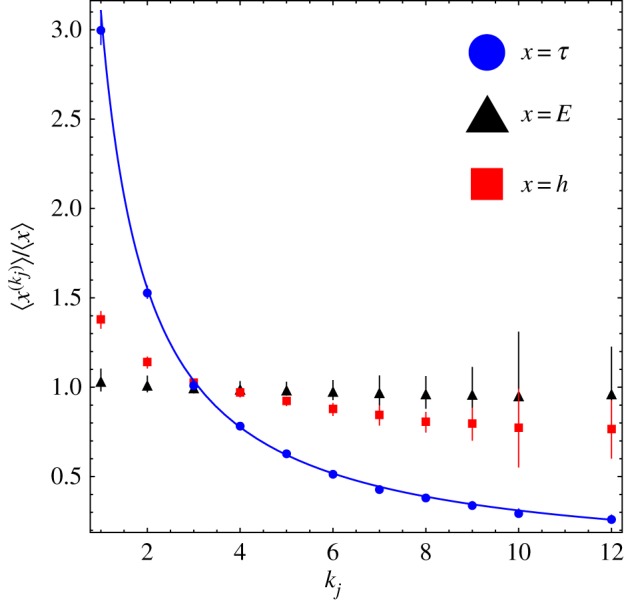
The dependence of the MFPT τij (blue circles), GENs Eji (black triangles) and mean infection time hij (red squares) as a function of the degree of a target node j. The MFPT is well fit by a τij ∝ k−1j, while hij and Eji have a much weaker dependence on the target node's degree. All constrained values 〈x(k)〉 are scaled by 〈x〉 (the unconstrained average over all nodes) to permit comparison.